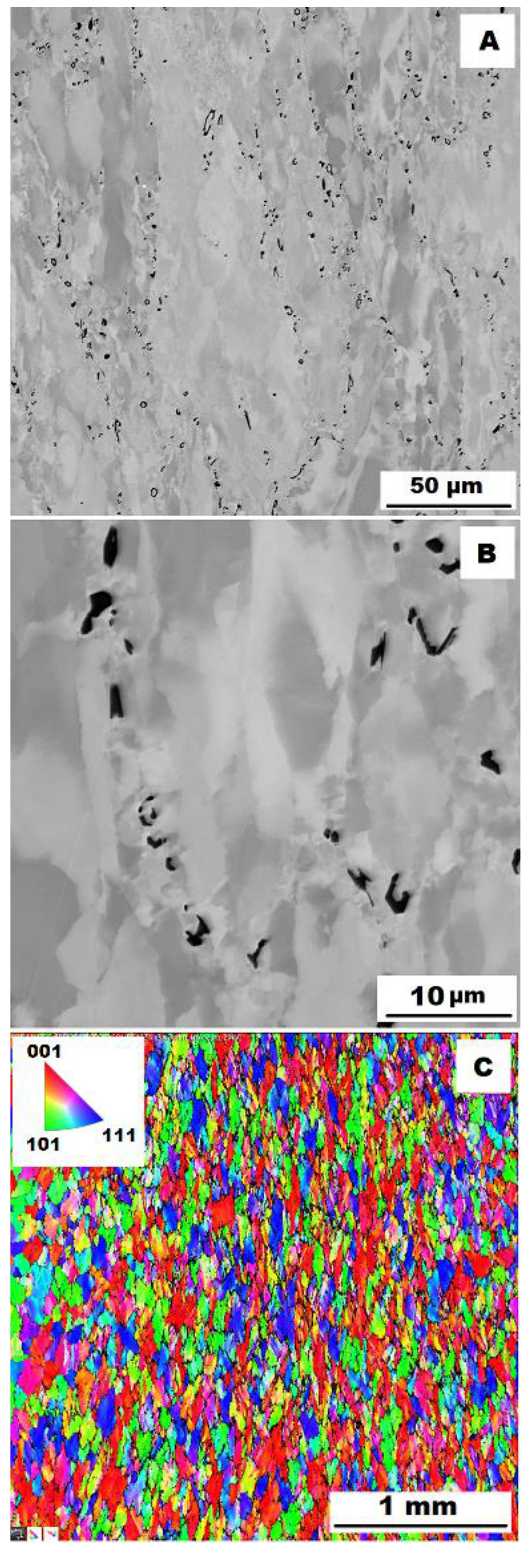
Figure 17. The structure of Fe – 28Al – 5Si – 2Ti – 1B HT 800/100 alloy after compression test at 600 °C. ( A ) Overview of the structure-10 kV, BSE. ( B ) Detail of the structure-10 kV, BSE. ( C ) EBSD map of grains-area 3 × 3 mm, step size 2 µm, 20 kV.